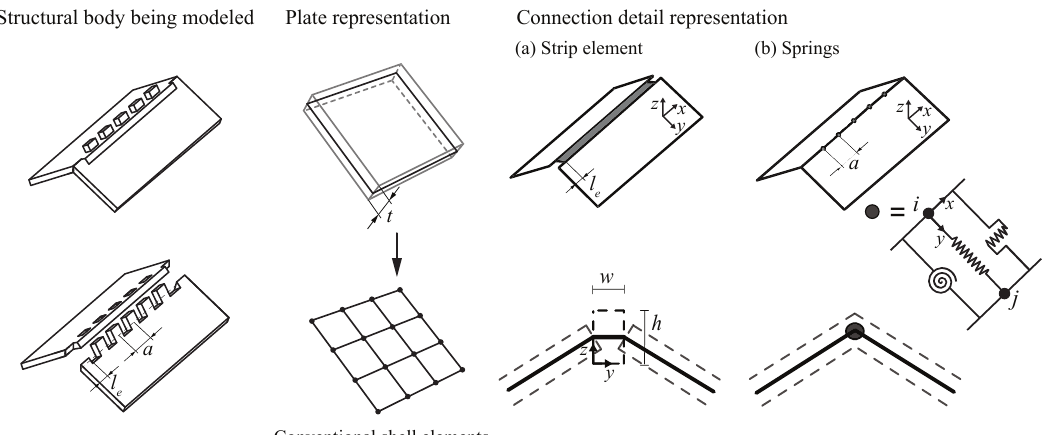
Figure 8. Schematic of numerical modelling of timber plates and MTSJ details. In the spring model shown here, one MTSJ tab is shown to be represented by only one set of three spring